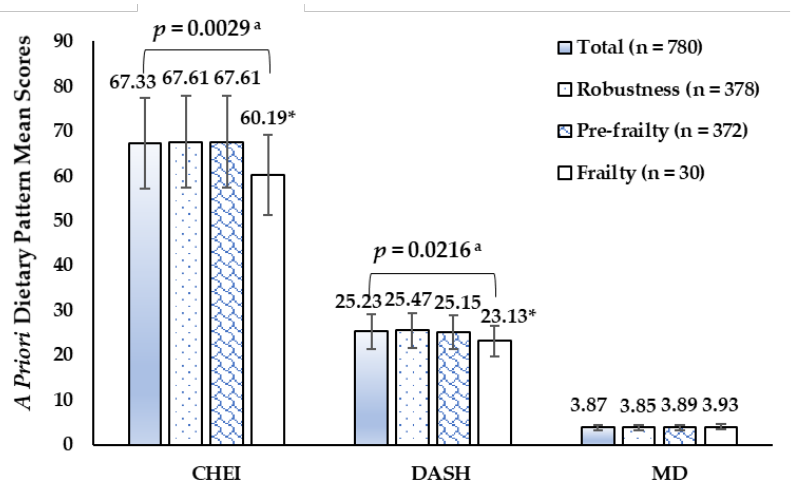
Figure 1. A priori dietary pattern mean sores of participants by frail status. a p -value between robust, pre-frail and frail participants by one-way ANOVA , Bonferroni post hoc test. * p < 0.05, compared with the means in Robust